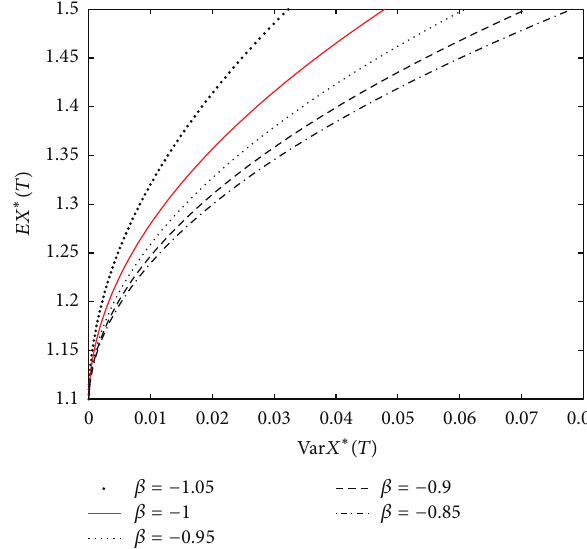
Figure 1: The efficient frontiers in mean-variance plane ( 𝛽 = −1.05, . .. ,−0.85 ).